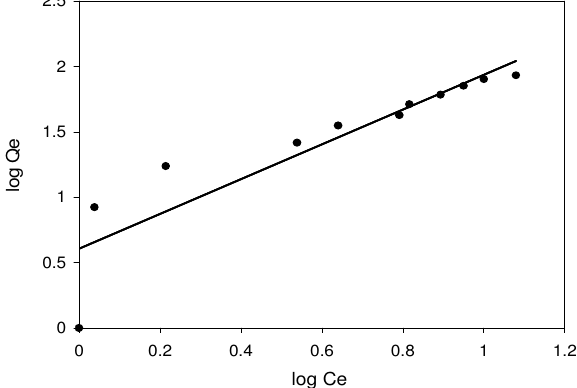
Figure 7 . Weber-Morris model for adsorption of Cr(VI) on trametes versicolor polyporous fungi